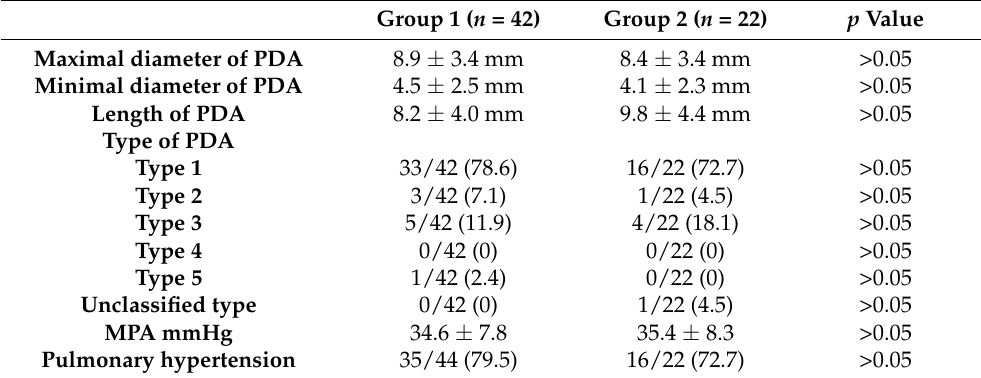
Table 2. CT findings in groups 1 (presence of pretest information) and 2 (absence of pretest information).